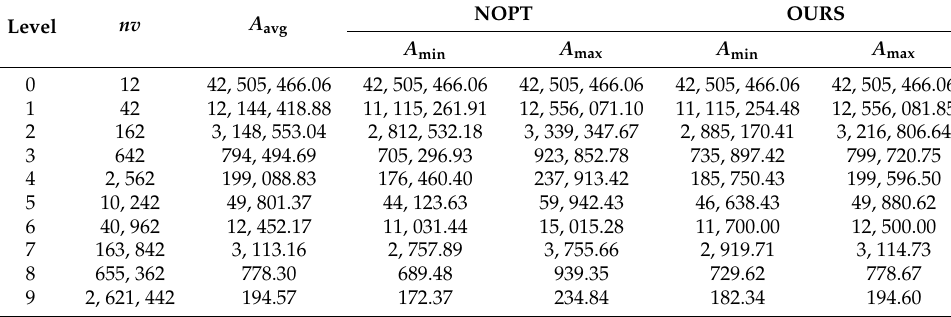
Table 1. A min , A max of spherical icosahedral grids (unit: km 2